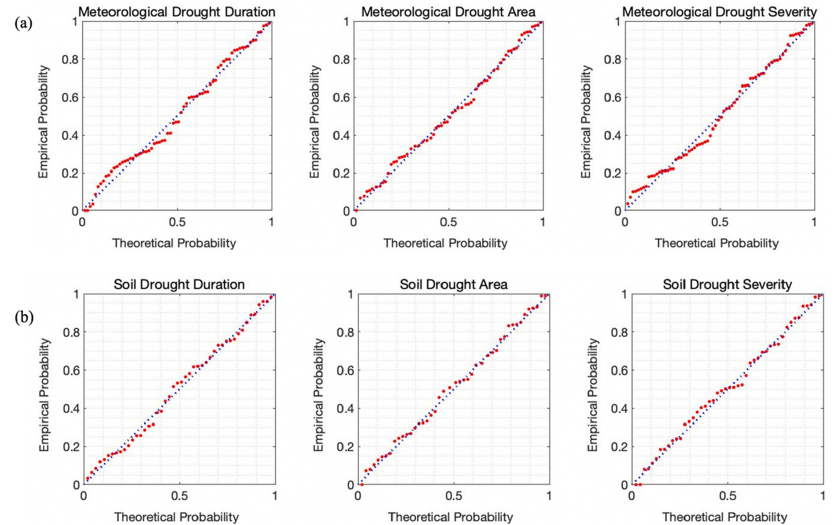
Figure 2. The fitting results of the drought parameters. ( a ) refers to the fit result of meteorological droughts, and ( b ) refers to the fit result of soil droughts. The x -axis is the cumulative probability estimated by the distribution functions, and the y -axis is the cumulative probability estimated by empirical functions. Table 1. The goodness of fits in the distributions of drought parameters.